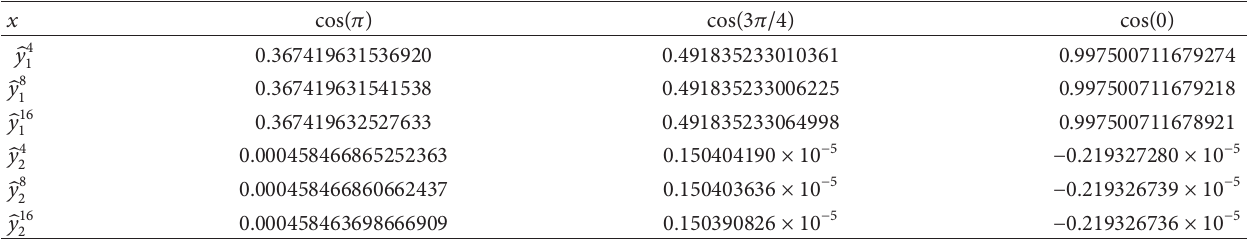
1 (𝑒 𝑖𝜔(𝑥−𝑡) /|𝑥 − 𝑡| 0.5 )𝑦(𝑡)𝑑𝑡 = 𝑒 𝑥 with 𝜔 = 10 6 . −1